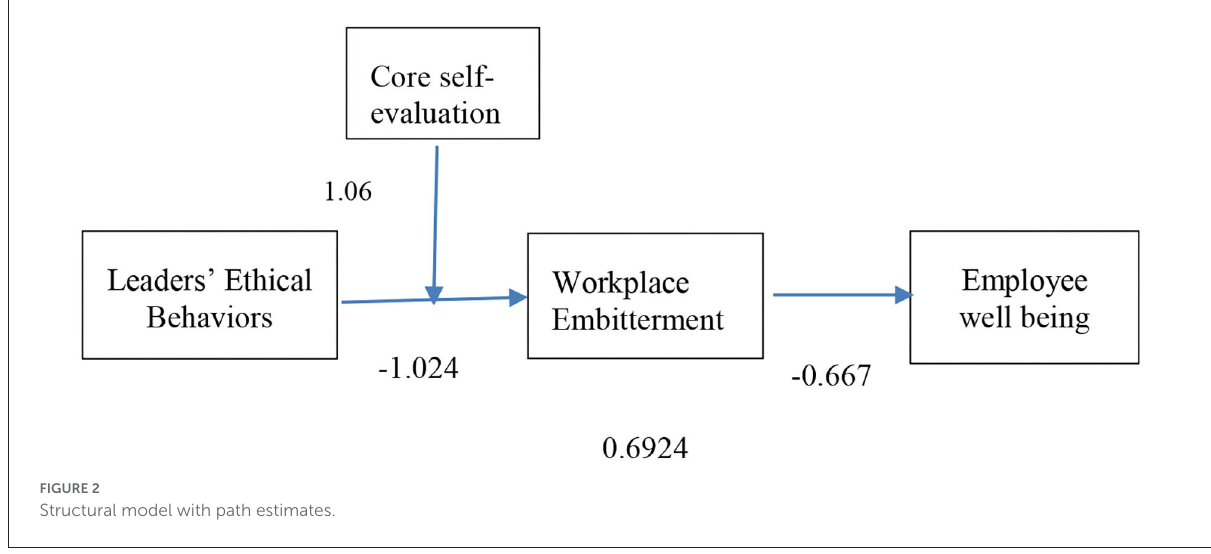
FIGURE2 Structural model with path estimates.